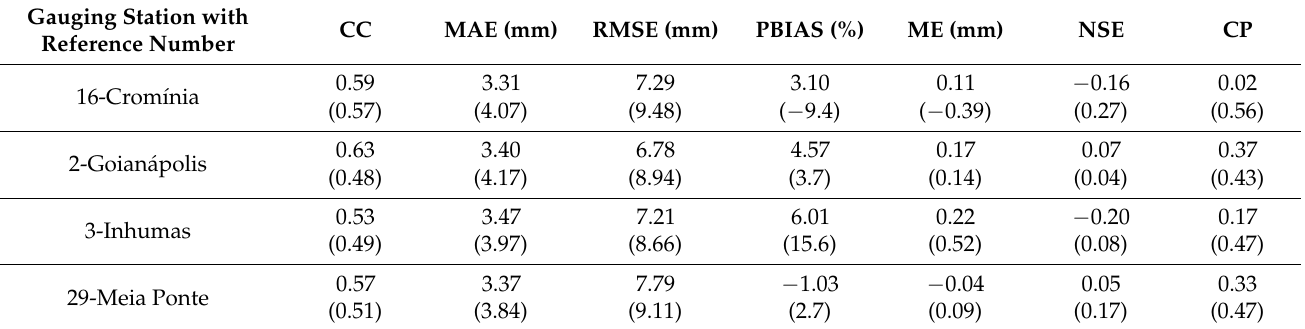
Table 3. Goodness-of-fit metrics for interpolated and raw (in parentheses) daily precipitation data from four gauging stations located in the Meia Ponte River